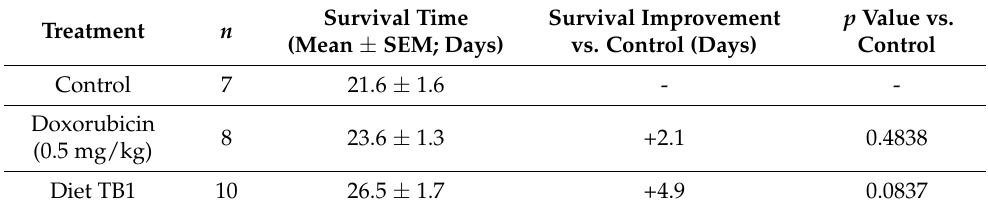
Table 3. Survival of mice with metastatic TNBC treated with diet TB1 or doxorubicin.